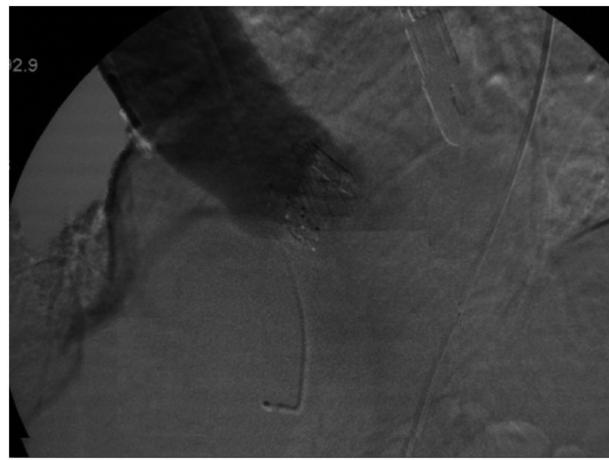
Fig. 8 – Angiographic aspect after transcatheter valve